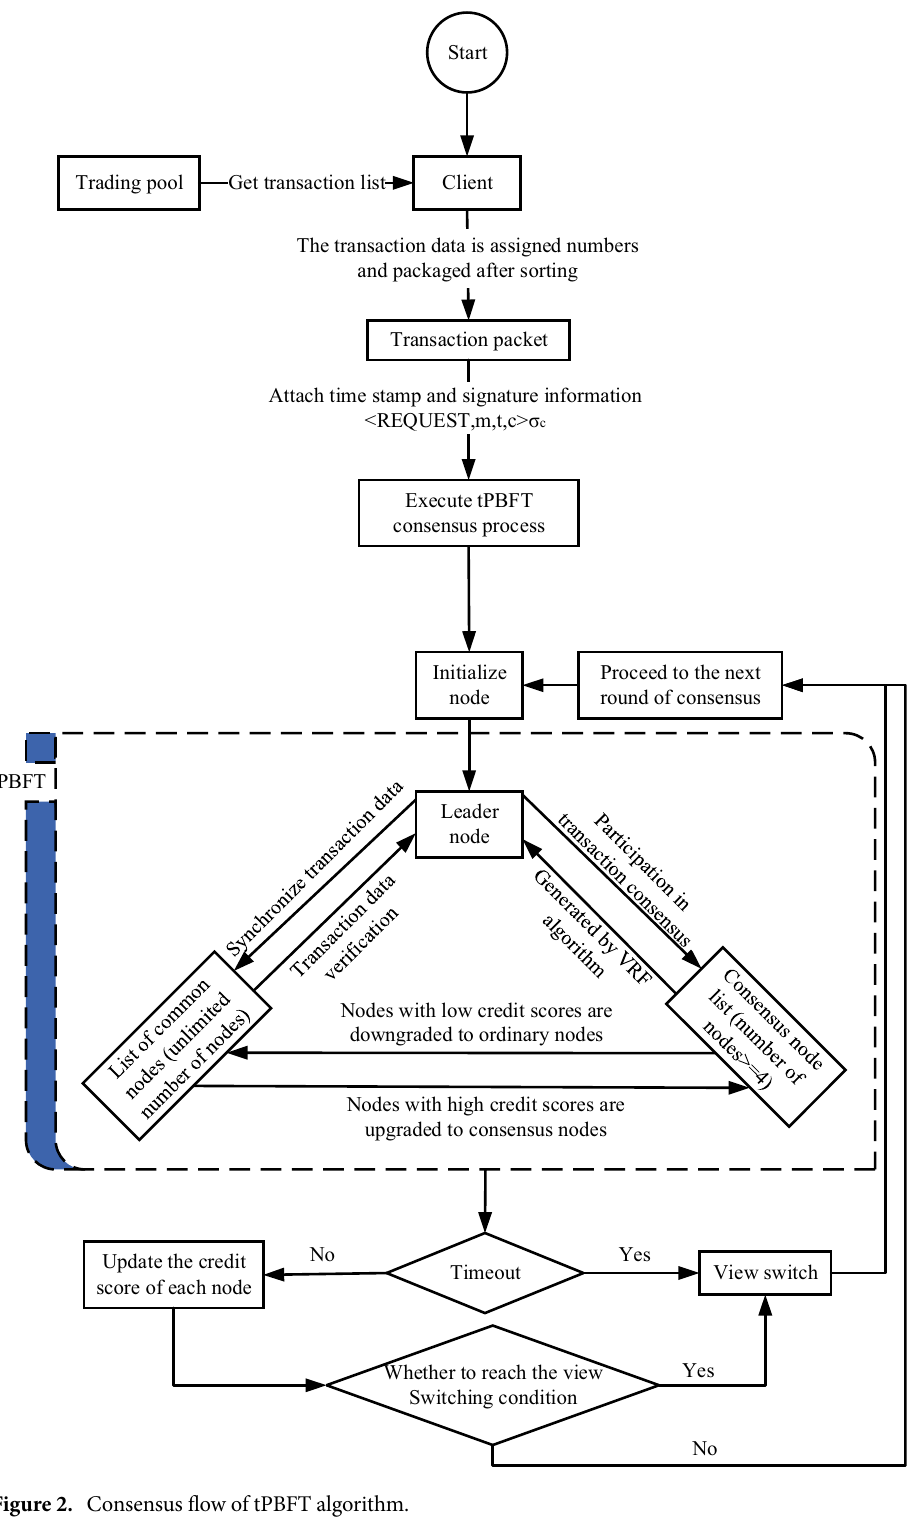
Figure 2. Consensus flow of tPBFT